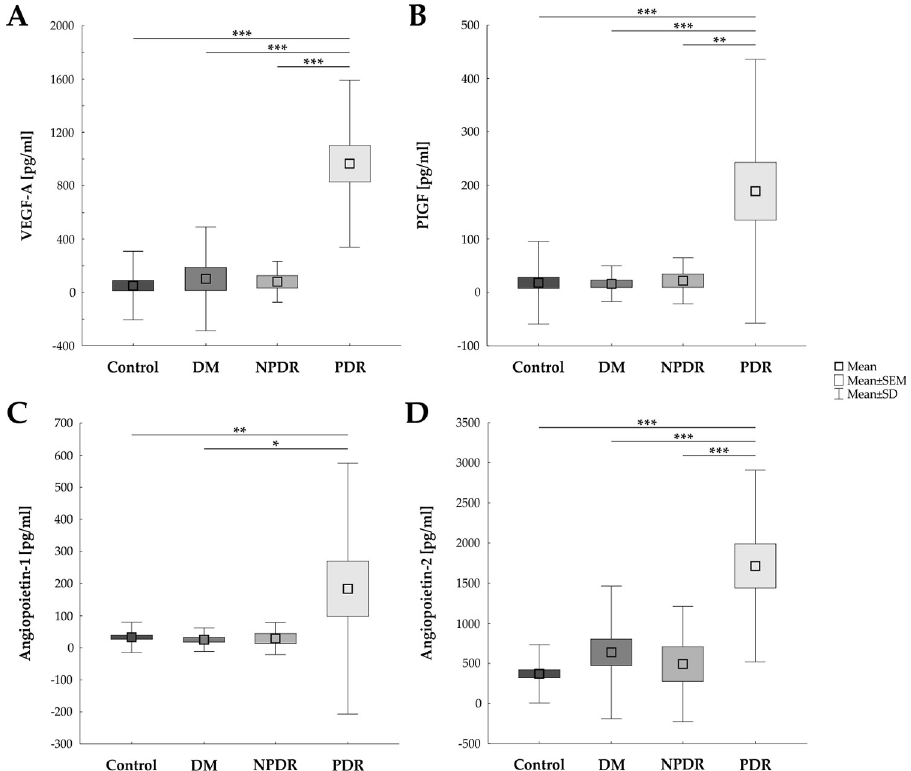
Fig 1. Up-regulation of different angiogenic factors in vitreous samples. A) VEGF-A was significantly up-regulated in vitreous samples of PDR patients in comparison to all other analyzed groups (all: p < 0.001). B) Additionally, PIGF was elevated in the PDR group in contrast to the control (p < 0.001), the DM (p < 0.001), and the NPDR group (p = 0.001). C) Angiopoietin-1 was increased in PDR samples compared to control (p = 0.005) and DM samples (p = 0.013). D) Angiopoietin-2 was also elevated in the PDR group in contrast to the other study groups (all: p < 0.001). DM: diabetes mellitus; NPDR: non-proliferative diabetic retinopathy; PDR: proliferative diabetic retinopathy (PDR); values are mean ± SEM ± SD; � p < 0.05; �� p < 0.01; ��� p <